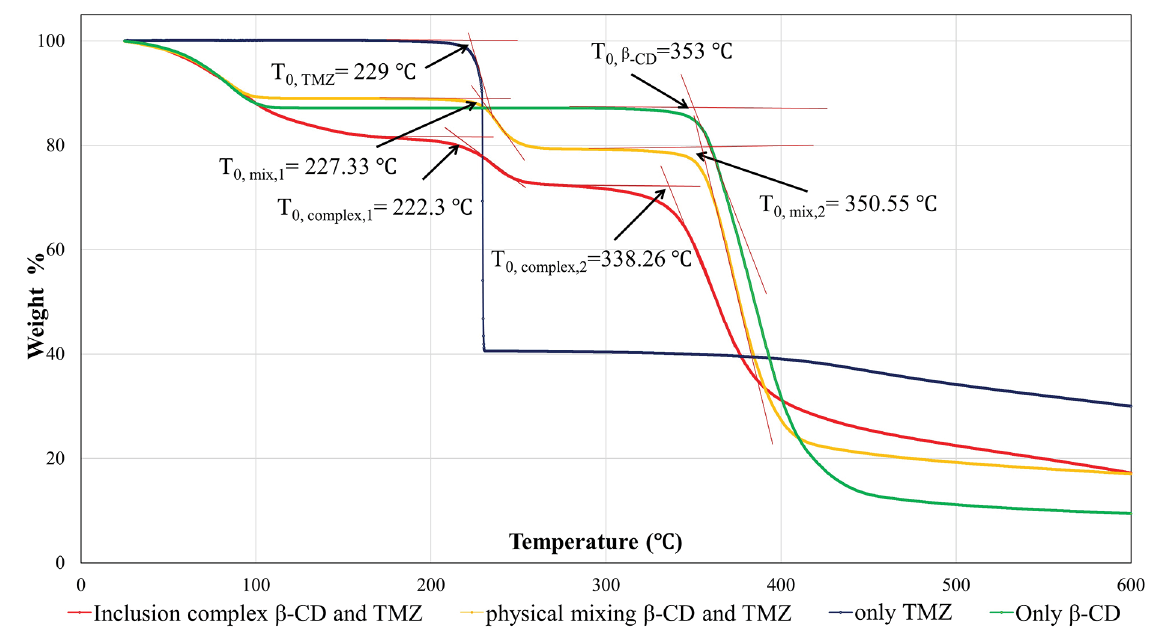
FIGURE 6 - TGA curves of TMZ- β -CD inclusion complex and physical mixing.